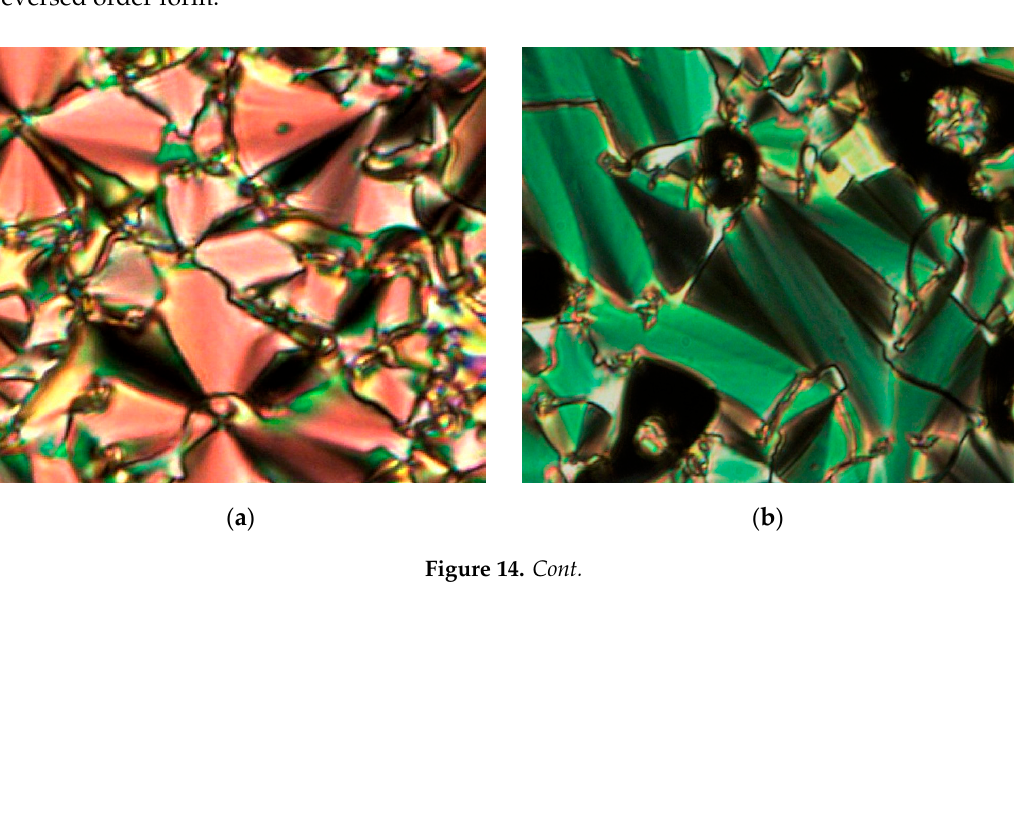
Figure 13. The optical photomicrographs of compounds 6c–e in the heating cycle showed the broken focal conic fans of SmC in the cooling cycle, ( a ) 150.11 ° C for 6c , ( b ) 144.67 ° C for 6d , and ( c ) 130.55 ° C for 6e (Magnification: 20 ×